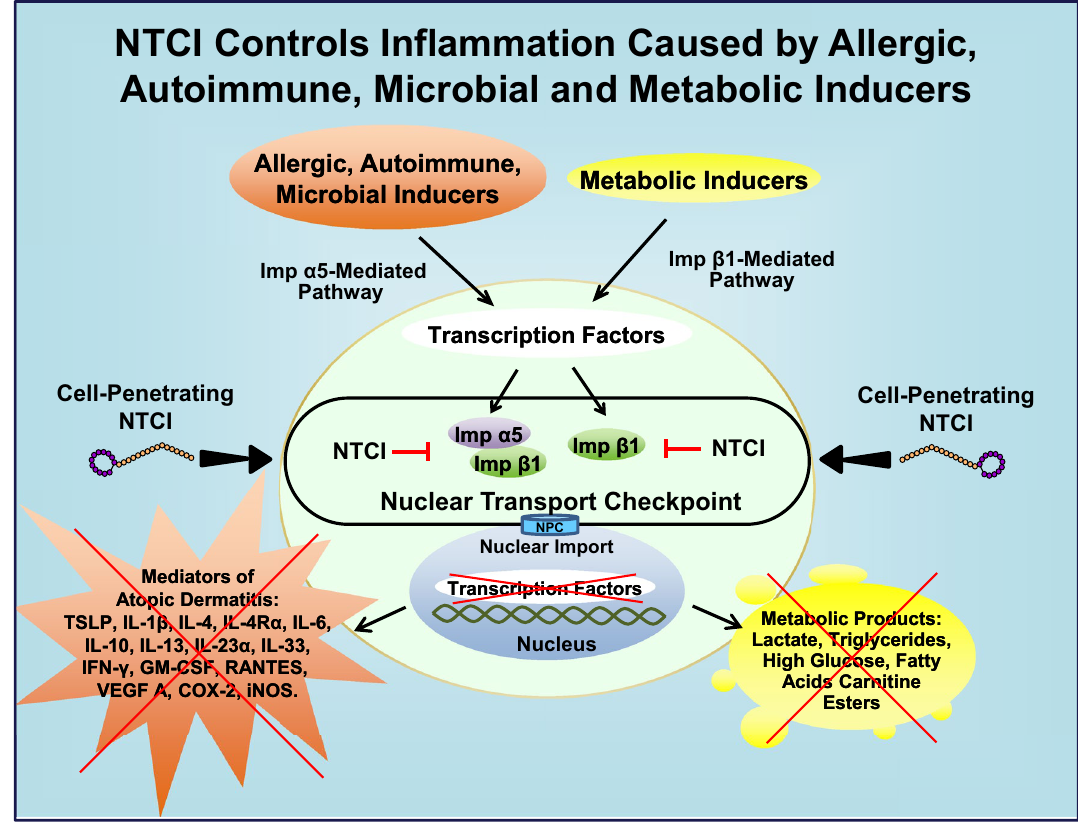
Figure 6. Mechanism of NTCI action in AD through targeted inhibition of importins α5 and β1 comprising the nuclear transport checkpoint. Proinflammatory Stress-Responsive Transcription Factors, which are activated by allergic, autoimmune, and microbial inducers of inflammation are ferried to the cell’s nucleus through an Importin α5-mediated pathway. Metabolic Transcription Factors, which are activated by overfeeding or inborn errors of metabolism are shuttled to the nucleus by Importin β1. NTCI stops binding of Transcription Factors to Importin α5 and Importin β1 thereby preventing the activation of the genes encoding mediators of